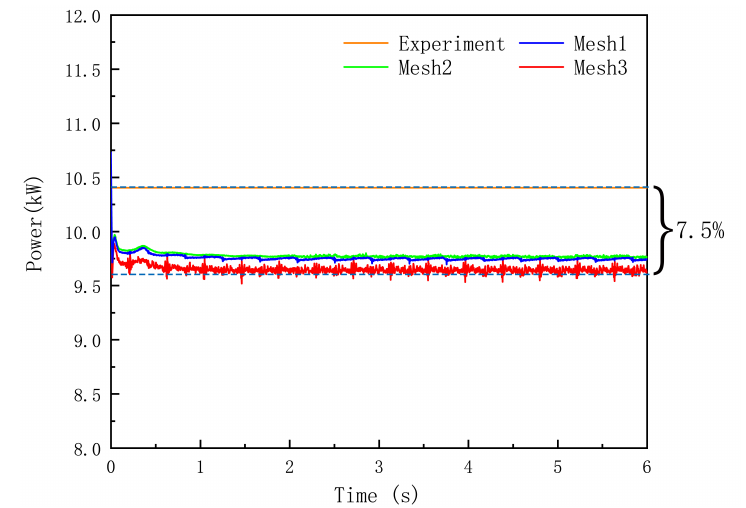
Figure 3. Comparison of simulation and experimental